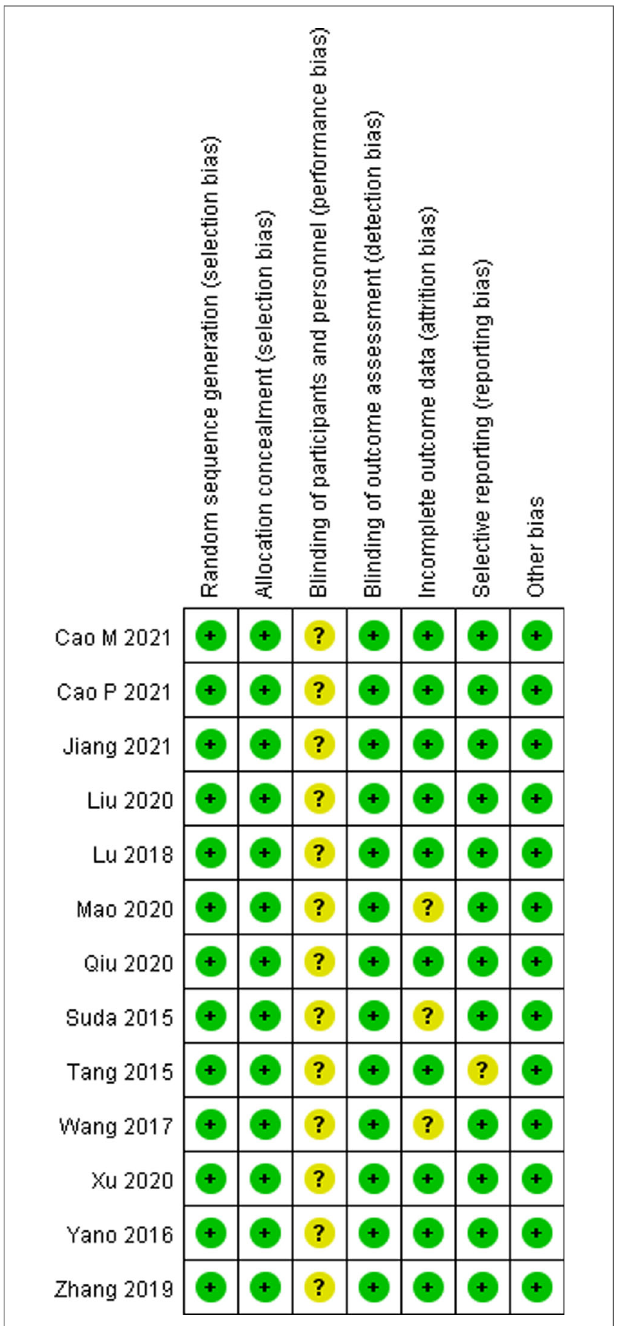
FIGURE 3 | Risk of bias summary according to the Cochrane collaboration ’ s